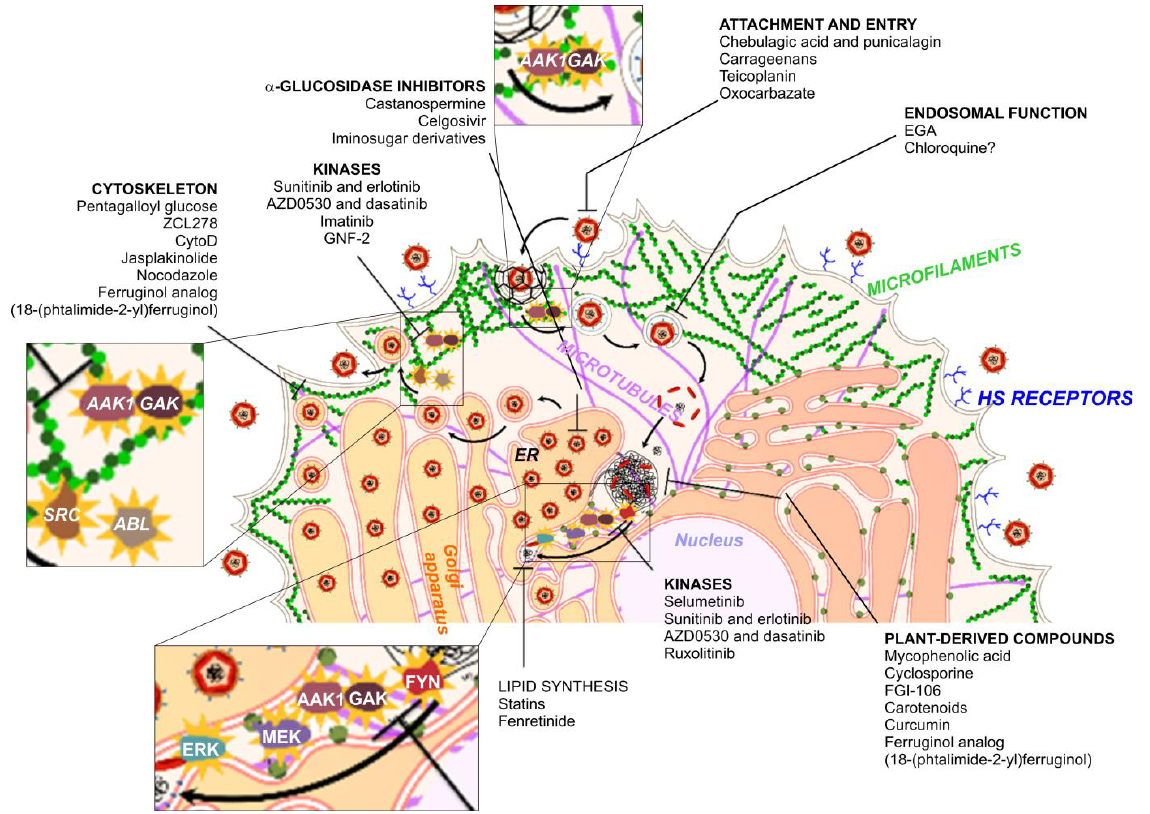
Figure 1. Host factors required for RNA virus entry and propagation. Host-targeted antivirals are indicated in the figure according to their presumed point of interference with the viral infectious cycle.